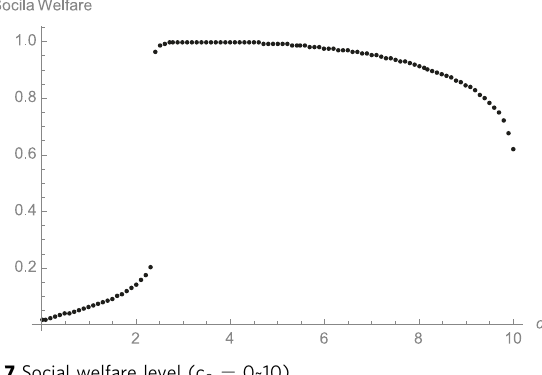
Fig. 7 Social welfare level (c 0 =